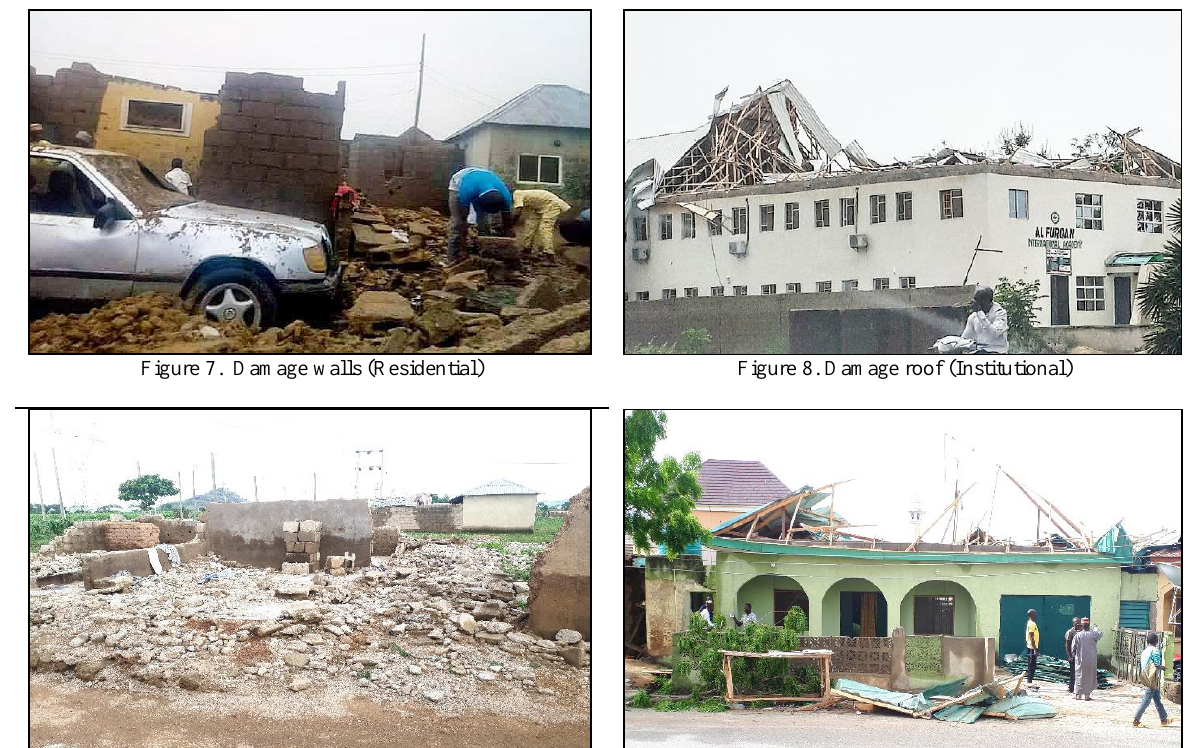
Figure 9. Completely Damaged building (Residential) Figure 10. Completely damaged roof